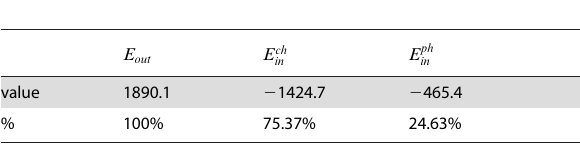
Where R in is the set of reactions of the metabolic network excluding EX_ & DM_ reactions (The text ‘EX_’ denotes an exchange reaction for a metabolite that can enter or leave the extra-cellular compartment. ‘DM_’ reactions are similar and signify compounds that the degradation pathway is unknown), D r G ’ m is the free energy change of i -th reaction in R in and v i is the i flux value of i -th reaction in R in .